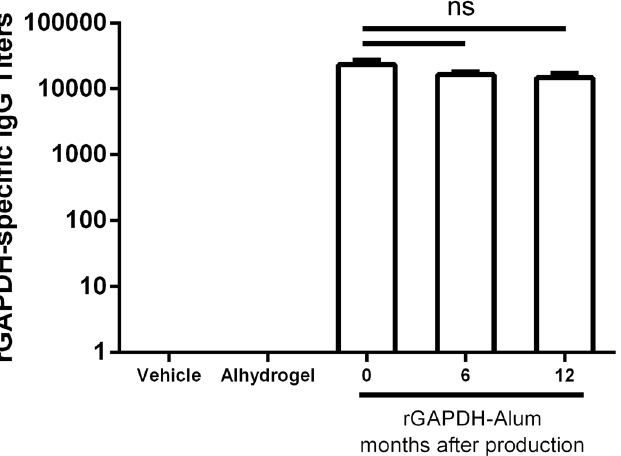
Fig 2. rGAPDH vaccine preserves its potency after prolonged storage at 4°C. rGAPDH-specific IgG titers of 4 female Balb/c mice per group, immunized three times with a three week interval, 24 h after the third immunization with PBS, Alhydrogel and 20 μ g of rGAPDH in a 1:40 PBS/Alhydrogel suspension prepared fresh (S0) or conserved at 4°C for 6 (S6) and 12 (S12) months. The ELISA plates were coated with rGAPDH and revealed with goat anti-mouse IgG — HRP. Titers are represented as minimal serum dilution necessary for the lost absorbance signal. One-way ANOVA with post-hoc Tukey ’ s t-test. ns — not